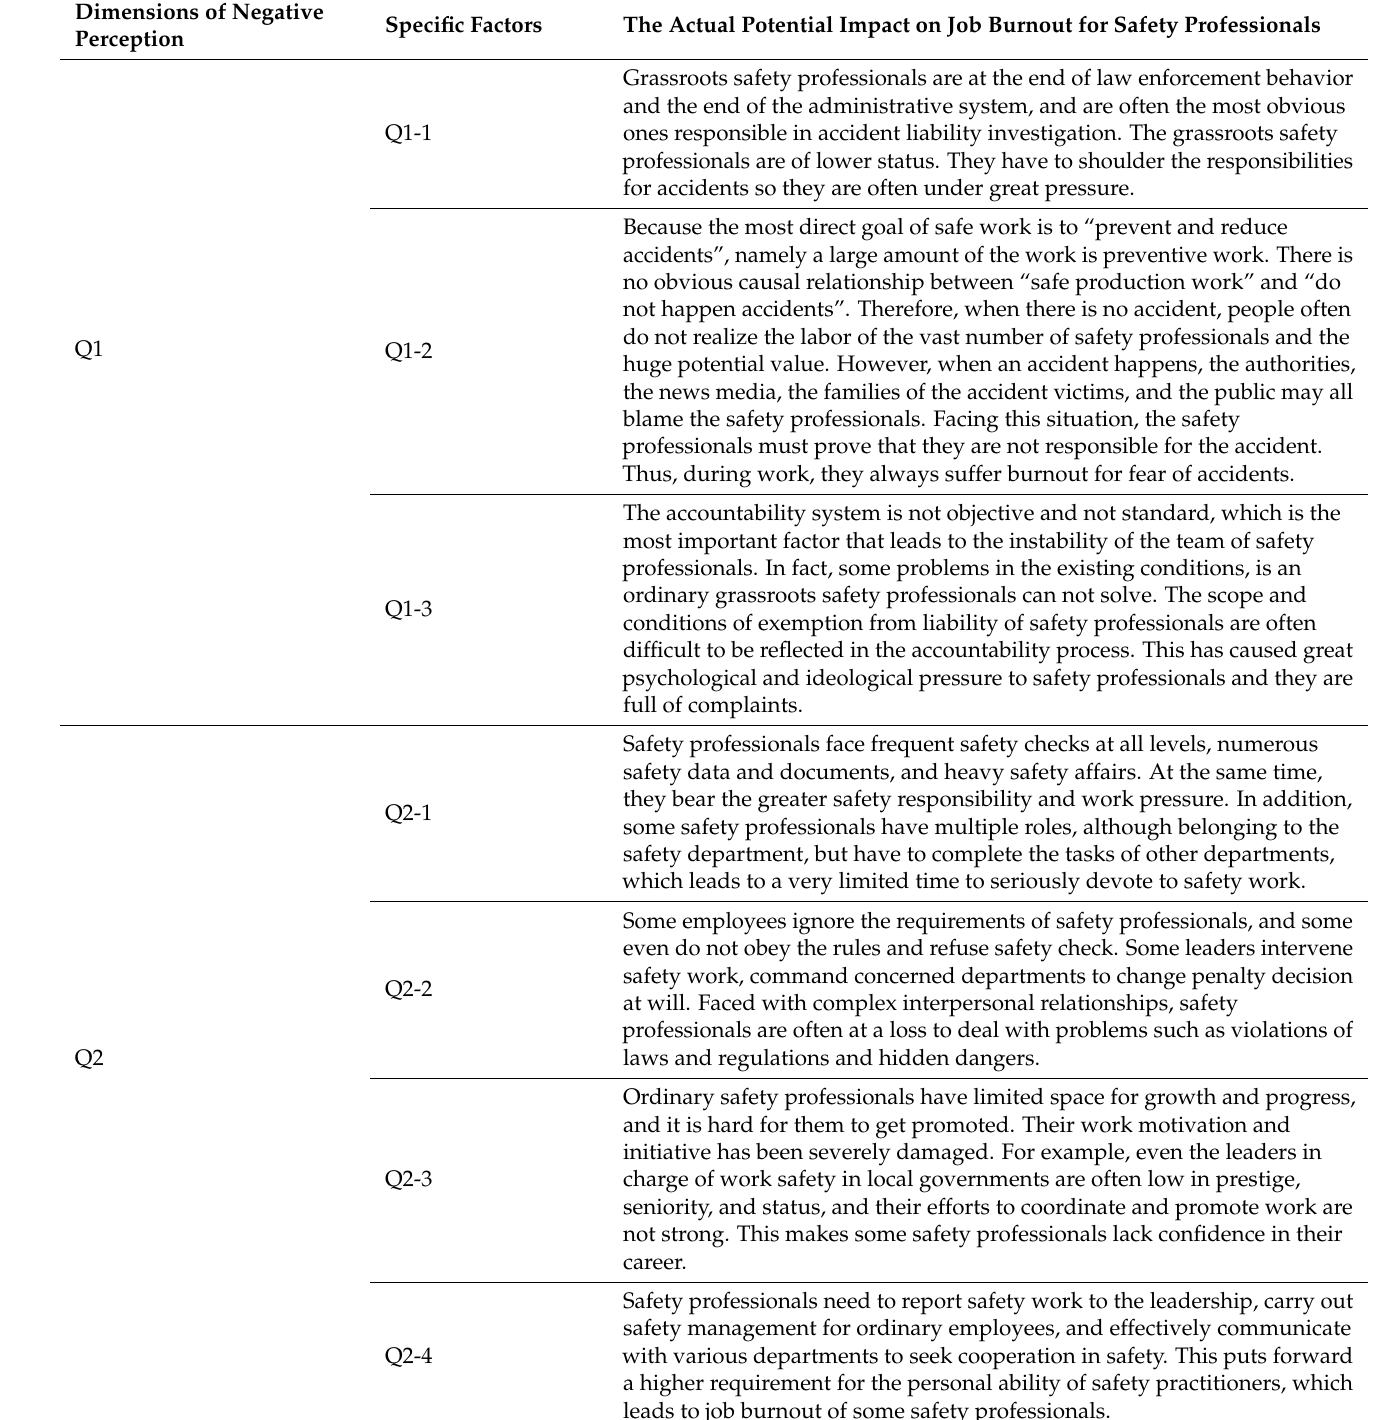
Table 12. The potential impact of 14 specific factors on the job burnout of safety professionals from the perspective of four negative